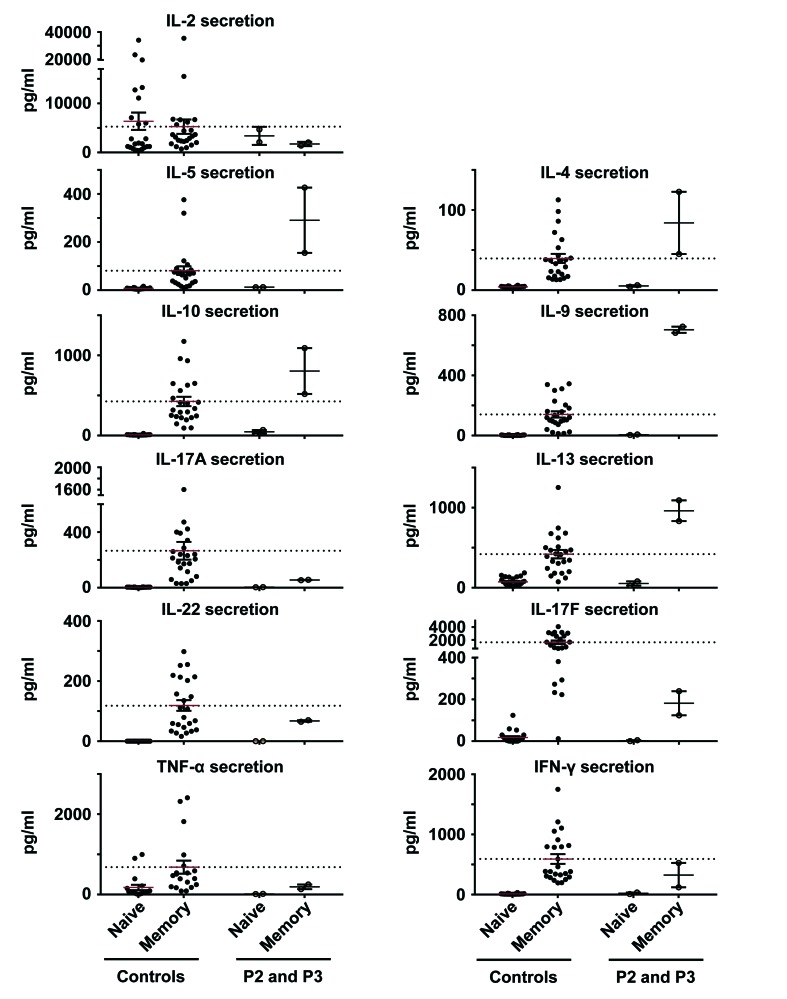
In vitro differentiation of CD4+ T cells from patients and controls. Naive and memory CD4+ T cells from healthy unrelated controls and patients (P2 and P3) were purified by sorting and cultured with TAE beads. The secretion of IL-2, IL-4, IL-5, IL-9, IL-10, IL-13, IL-17A, IL-17F, IL-22, IFN-γ and TNF-α was measured five days later. No significant differences were observed between healthy unrelated controls and patients.